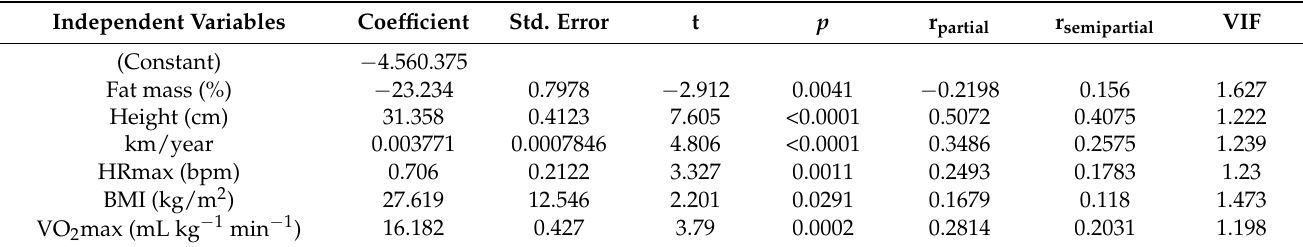
Table 4. Multiple regression model to predict peak power output